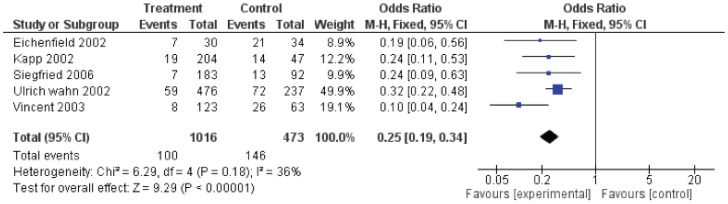
Analysis of Study withdrawals due to unsatisfactory therapeutic effects.